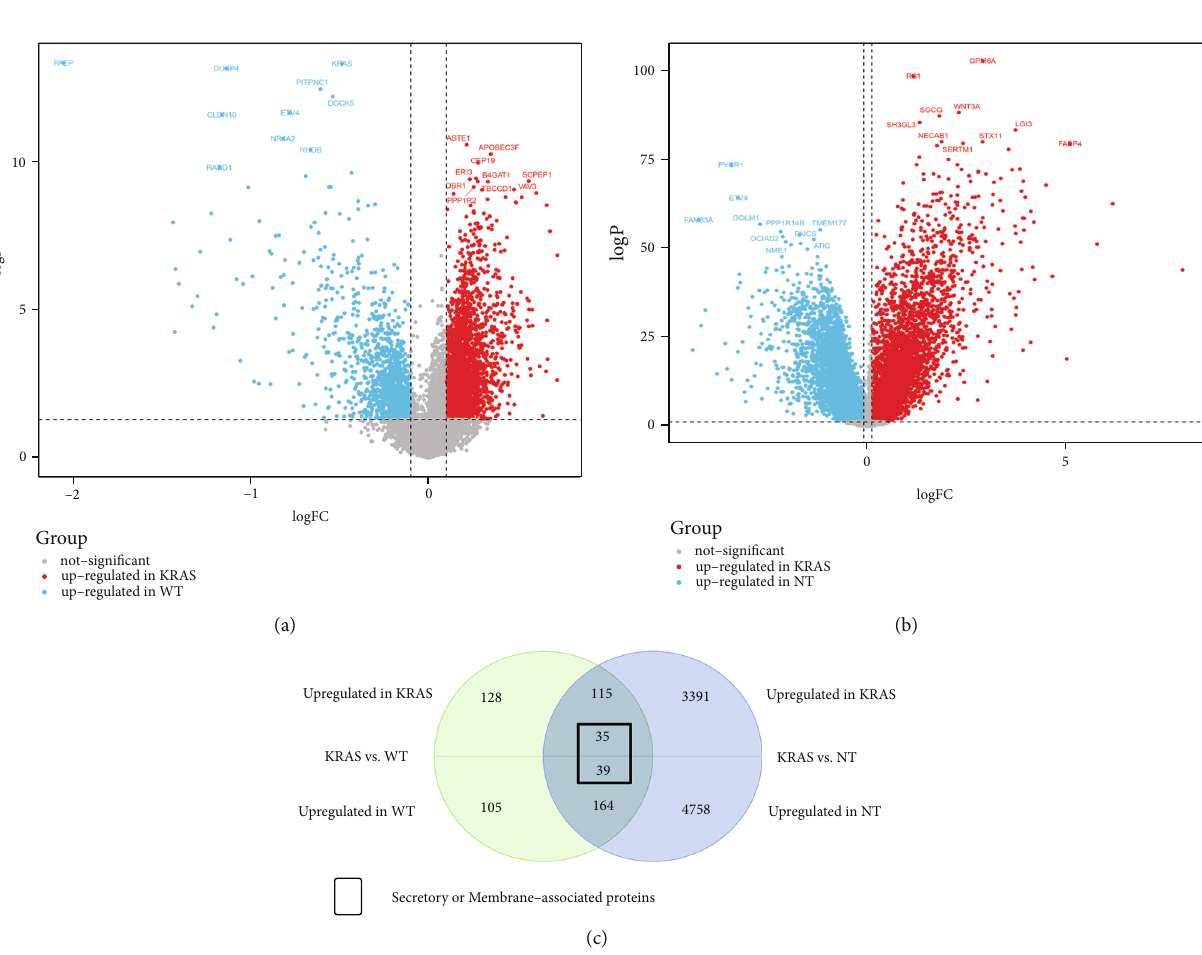
Figure 1: Selection for secretory or membrane-associated DEGs: (a) the volcano plot showed the di ff erentially expressed genes in KRAS vs. WT group; (b) the volcano plot showed the di ff erentially expressed genes in KRAS vs. NT group; (c) the Wayne diagram showed selection for secretory or membrane-associated